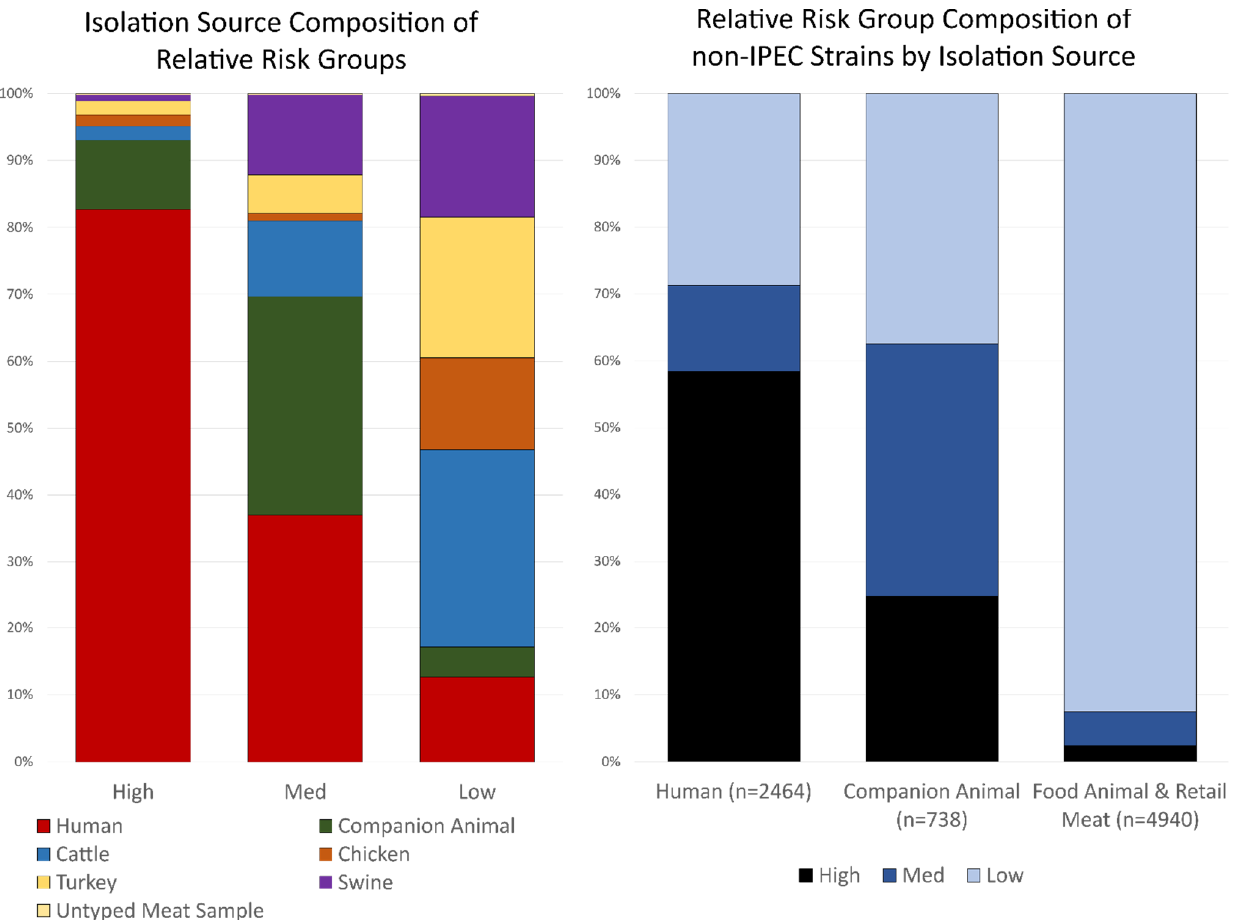
Figure 2. ( left ) Bar graph representation of isolation sources divided into relative risk groups. Isolation sources are the combined results from all contributing organizations. ( right ) Evaluation of the relative risk group composition of strains from humans (PulseNet and non-PulseNet), companion animals (Vet-LIRN and APHIS), and food animals + retail meats (USDA-FSIS and CVM-NARMS). We then evaluated the composition of the relative risk groups by their E. coli phylo- genetic groups (Supplemental Table S4). The major phylogenetic groups consisting of at least 20% of the relative risk groups were A, B1, B2, and D (Table 3). In the high relative risk group, 56.2% of the isolates belonged to B2, and 20.4% belonged to the D phylogenetic group. Among the medium relative risk group, 59.3% of isolates belonged to B2, and 20.2% belonged to phylogenetic group A. Phylogenetic group B1 was most common in the low relative risk group, at 48.1%, followed by phylogenetic group A, at 28.6%. In the remaining phylogenetic groups, groups C and G were most common in the low relative risk group, at 3.8% and 3.7%, respectively, while groups E and F were found most often in the high relative risk group, at 4.6% and 4.7%, respectively. A phylogenetic group comparison to virulence group revealed two main clusters of high relative risk virulence groups. In the first cluster, more than 70% of the isolates from high relative risk groups 26, 12, 33, 35, and 16 belonged to phylogenetic group B2. The second cluster of high relative risk groups of 5, 13, 14, 17, and 3 were represented by phylogenetic groups E, D, and